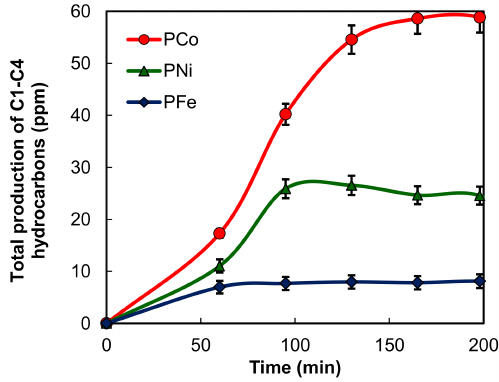
Figure 6. Molar production vs. time obtained with the